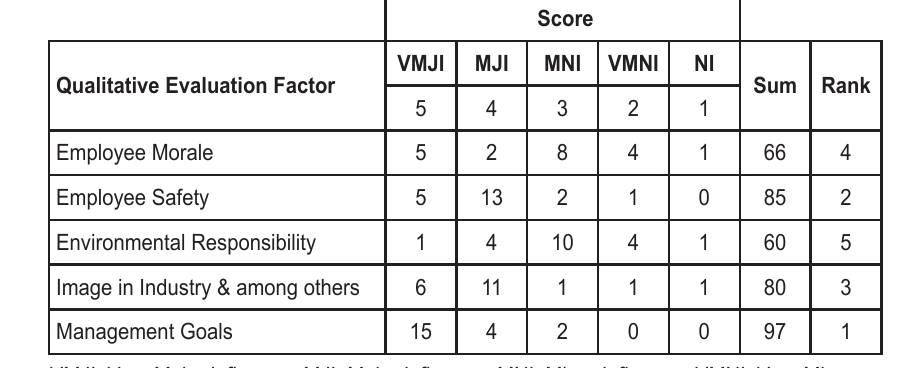
Table 2: Qualitative evaluation